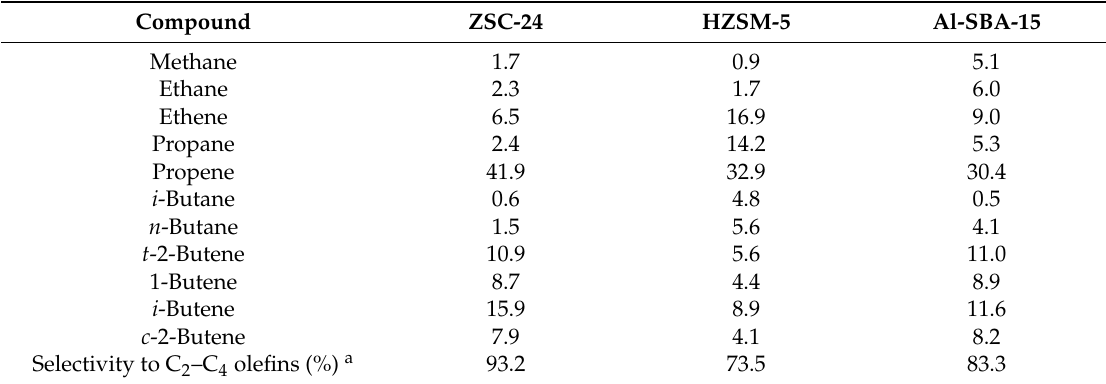
Table 1. Hydrocarbon gas compositions obtained in the catalytic cracking of waste cooking oil over ZSC-24 material relative to HZSM-5 and Al-SBA-15 catalysts. Adapted from